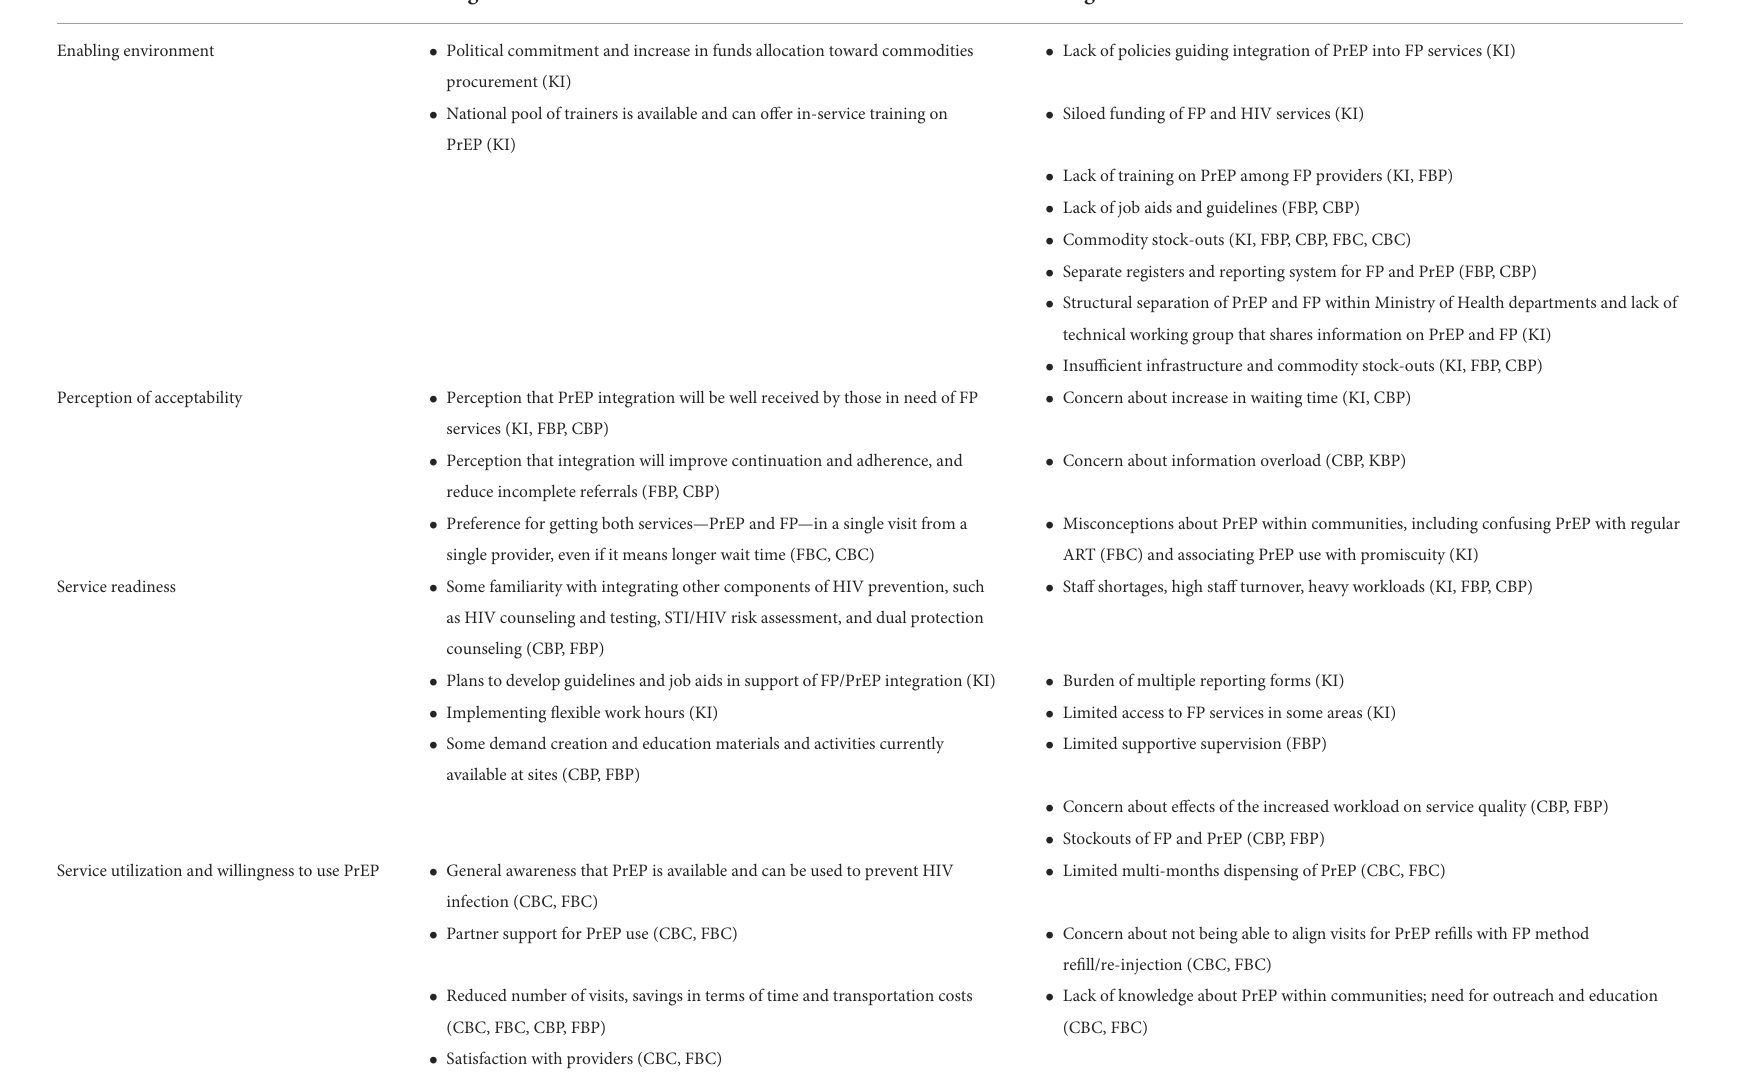
TABLE 2 Barriers and facilitators to integrating PrEP into FP services by